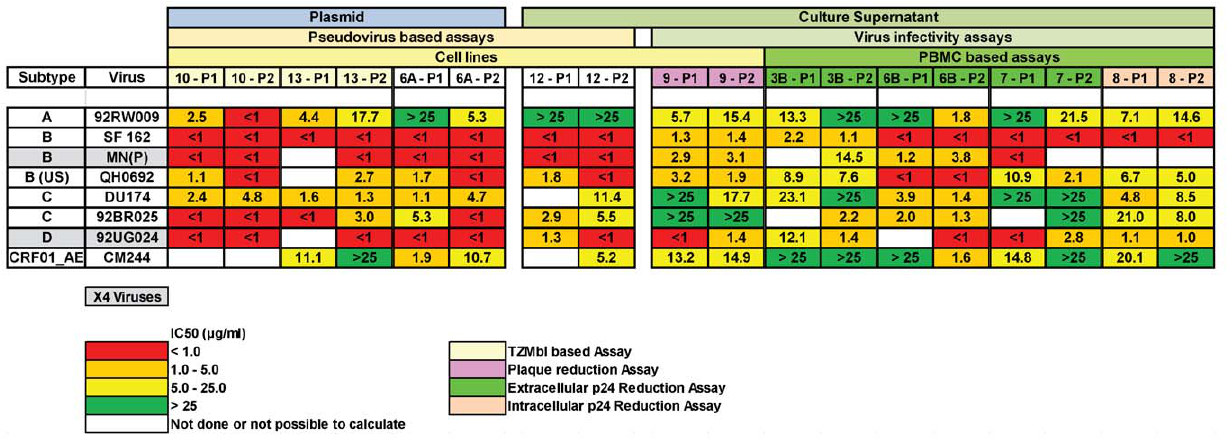
Figure 2. Mean inhibitory concentration (IC) 50 values for duplicate assays performed with TriMab and virus as indicated in the NeutNet Phase I (P1) and Phase II (P2) study. The cells are colour coded: green, poor or no neutralization, IC50 . 25 m g/ml; yellow, IC50 5–25 m g/ ml; orange, IC50 1–5 m g/ml; red, IC50 , 1 m g/ml; white, no results available. Assays are grouped on the basis of several criteria: (1) the use of plasmids or culture supernatants as a source of HIV-1; (2) fusion based assays or infection based assays, either with pseudotyped virus or replication competent virus; and (3) the use of cell lines or PBMC. Laboratories performing the assays are numbered (see Figure 1 for reference) and colour coded: blue, TZMbl assay or PSV/plasmid assays; green, PBMC assays using extracellular p24 as readout; pink, plaque reduction assay. In the listing of viruses, to the left, the cells of X4 viruses are labelled grey, the cells of R5 viruses are white.